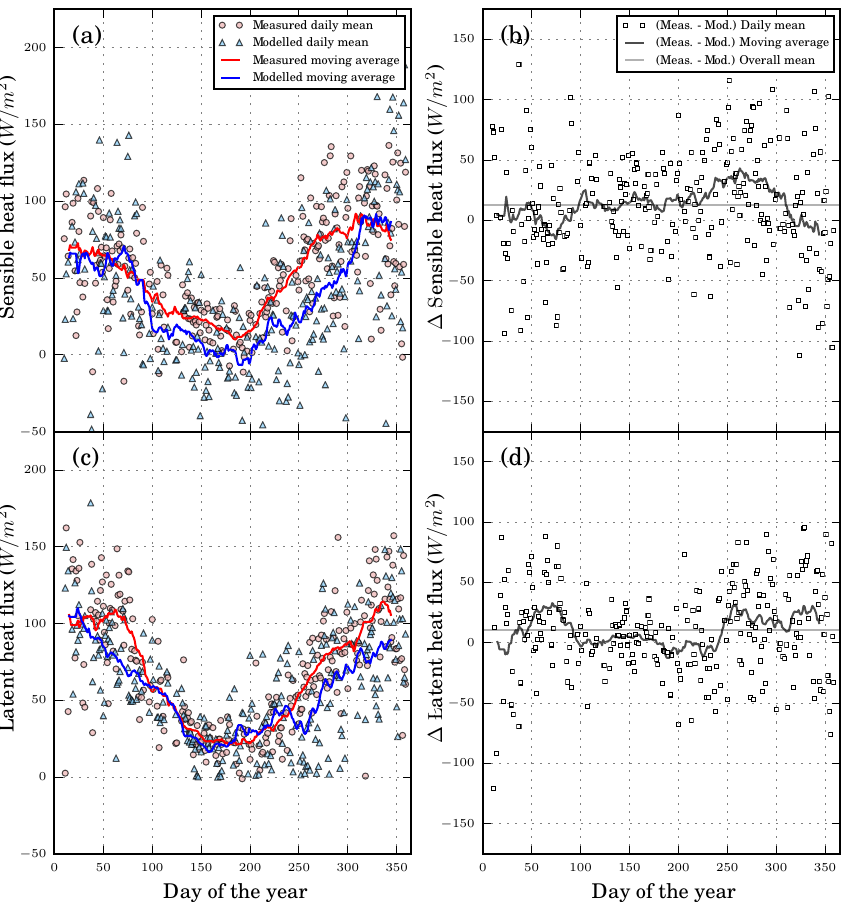
Figure 4. Daily mean for measured (circles) and modelled (triangles) over a year-long run for (a) sensible heat flux; (b) difference between measured and modelled sensible heat flux; (c) latent heat flux; and (d) difference between measured and modelled latent heat flux; 1 in every 5 data points is shown, for clarity. Thick lines show the respective 20-day moving average for each data set. Graphs (b) and (d) also show the overall mean of individual data